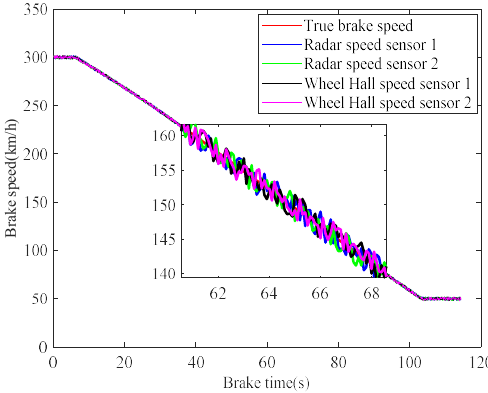
Figure 10. Train braking speed measurements.